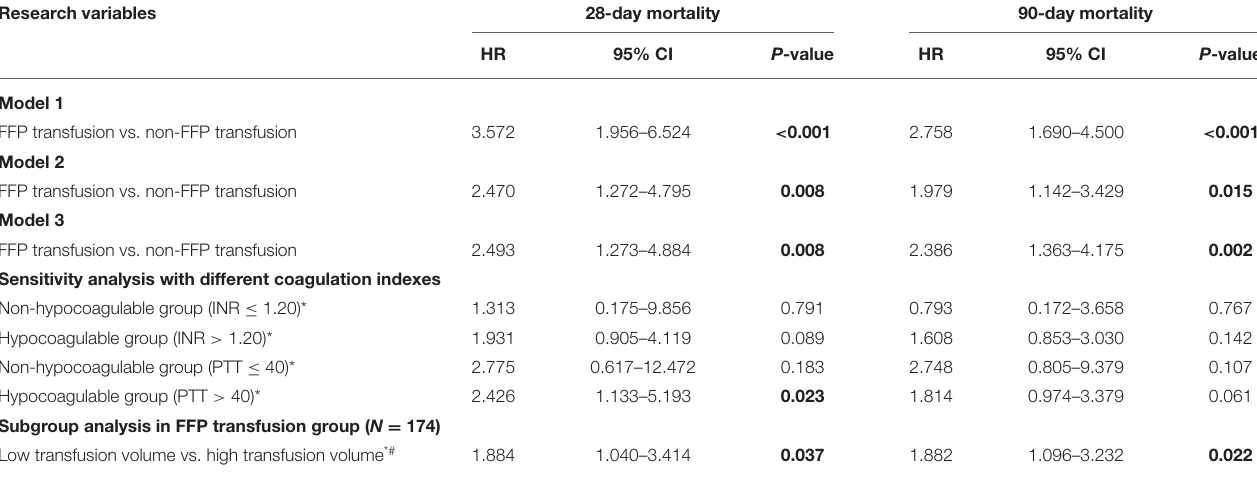
TABLE 5 | External validation with our hospital